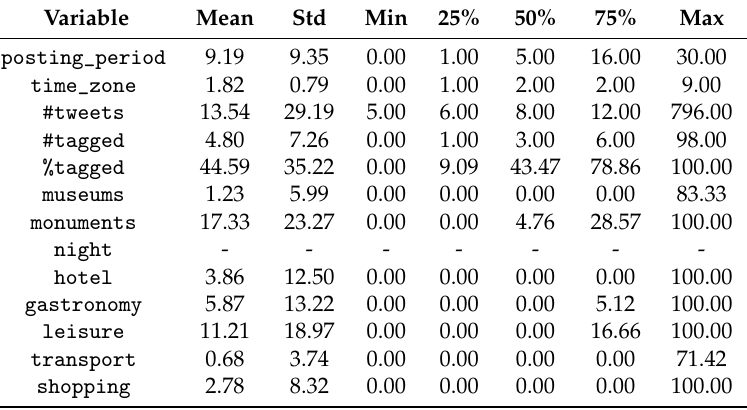
Table 5. Valencia dataset